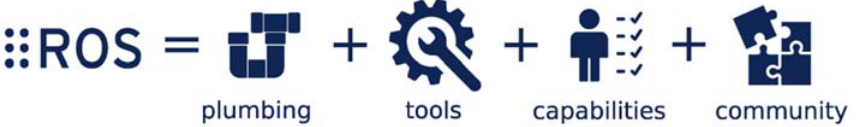
Figure 1. The ROS ecosystem is composed of multiple elements: (i) plumbing: a message ‐ passing system for communication; (ii) tools: a set of development tools to accelerate and support application development; (iii) capabilities: drivers, algorithms, user interfaces as building blocks for applications; (iv) community: a large, diverse, and global community of students, hobbyists and multinational corporations and government agencies.